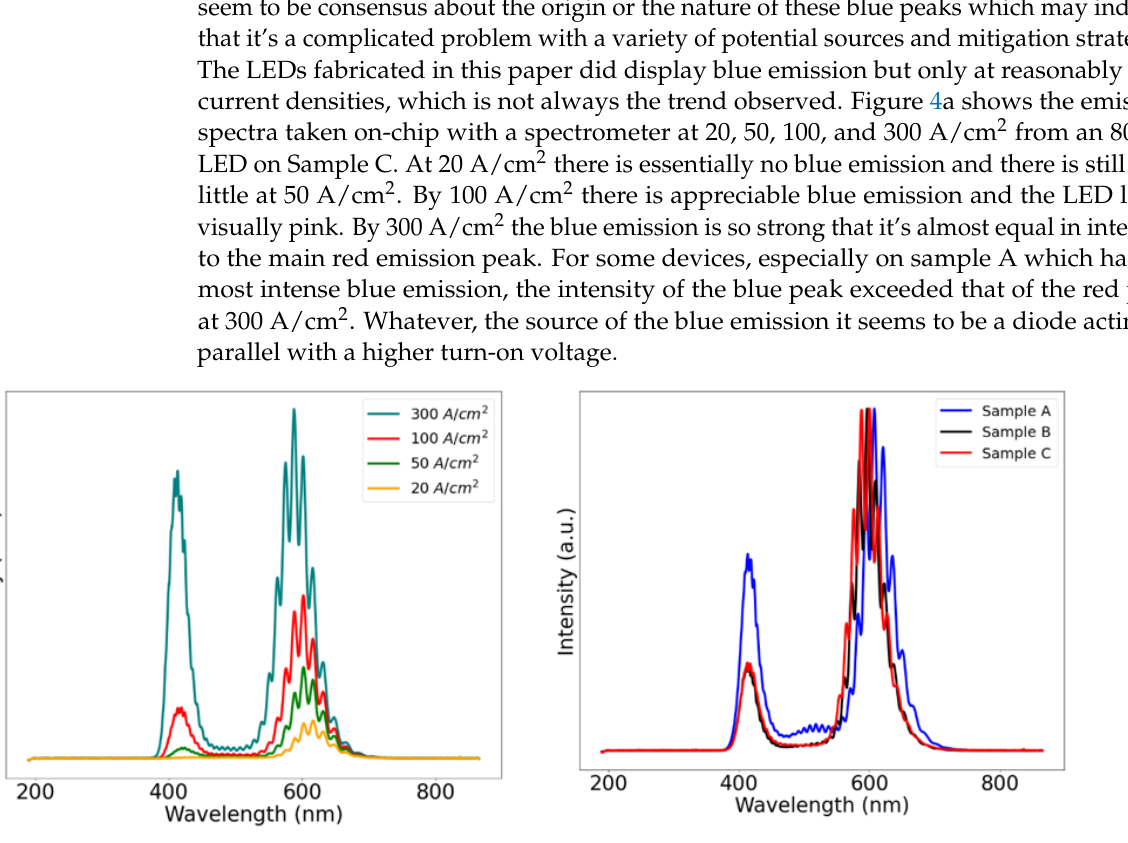
6 of 11 Table 1. Statistics on v-pit distribution for 3 LEDs with different SL structures . Sample